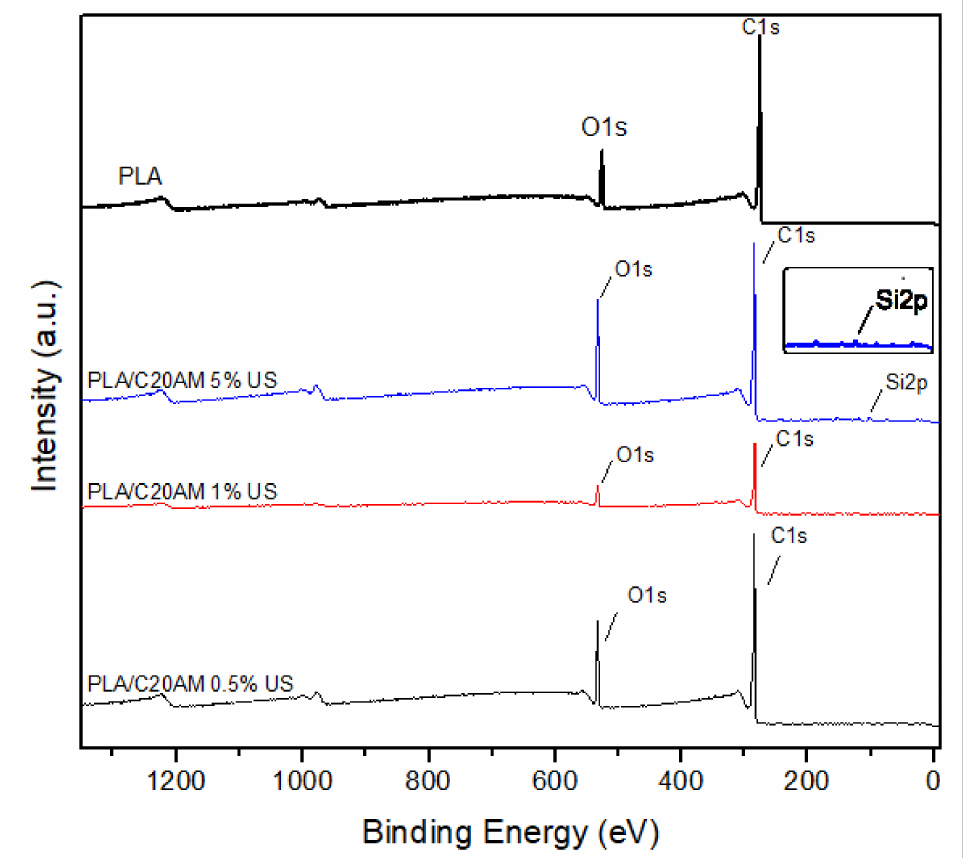
Figure 8. XPS spectra of PLA and nanocomposites were